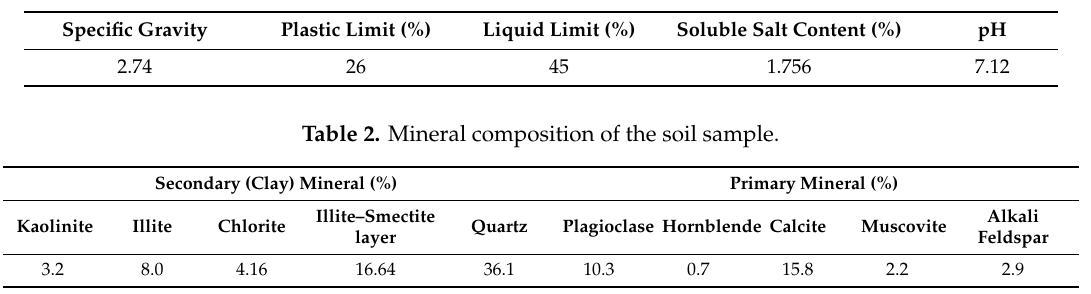
Table 1. Basic physical properties of the soil sample.